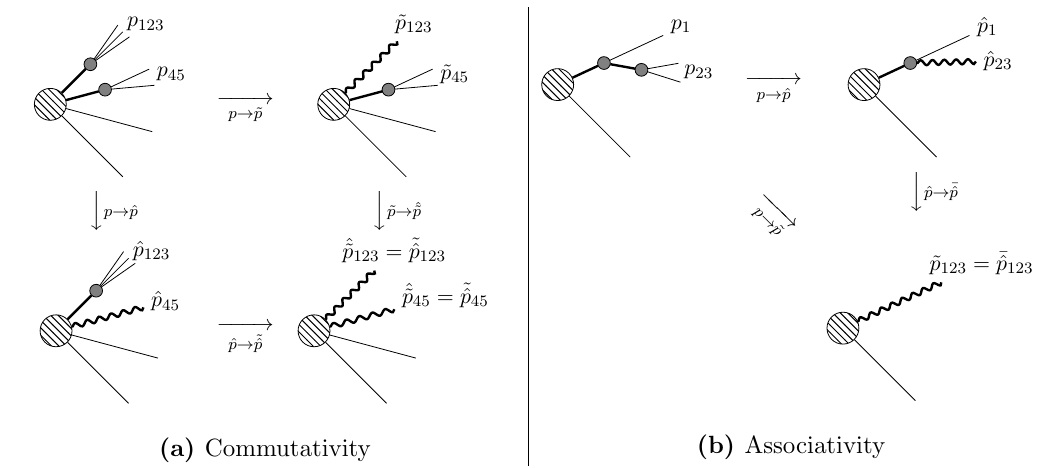
Figure 2. Schematic illustration of mapping properties. We denote massive parent momenta by a thick line splitting and their massless mapped version by a wavy line. In the case of associativity, we show a speci(cid:12)c iterated mapping that (cid:12)rst groups 2 an 3 but any other choice yields the same (cid:12)nal momentum if the property